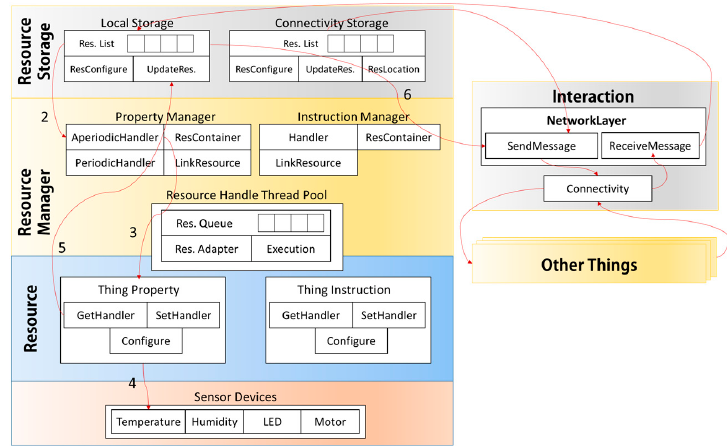
Figure 9. Resource management layer structure.